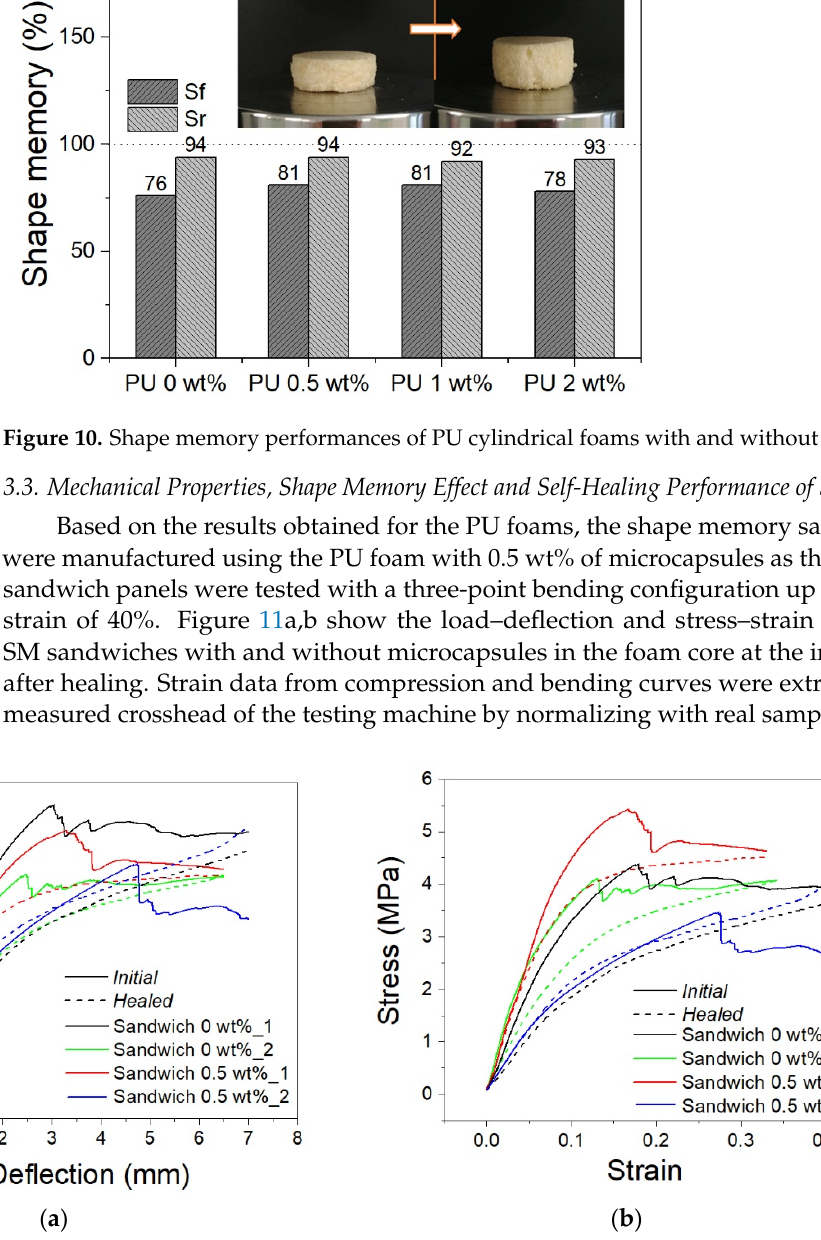
Figure 10. Regardless of the presence of microcapsules, the results show that the PU foam has a shape recovery ability of about 94% and a fixity one of about 79%.